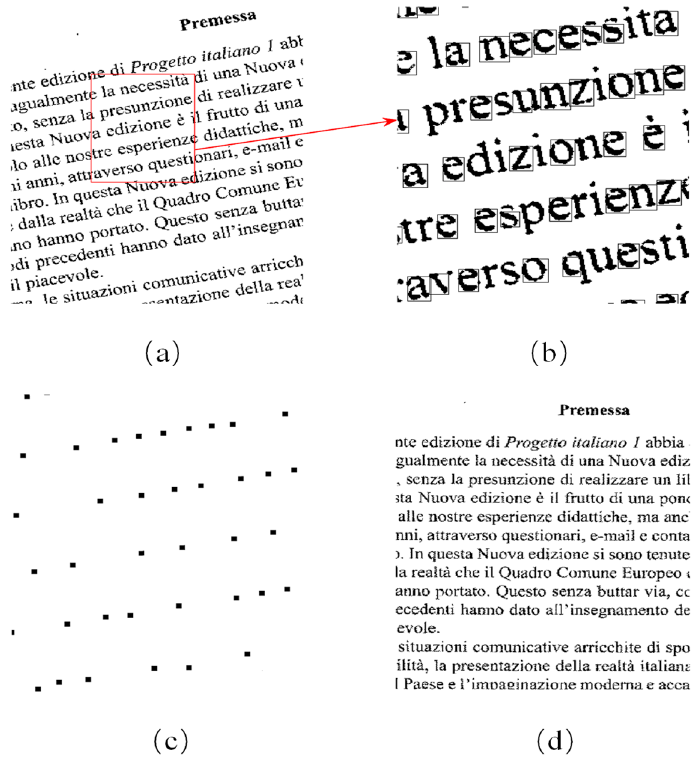
Figure 4. Document skew detection and correction: ( a ) original document image; ( b ) the document image with bounding boxes; ( c ) the positions of ECCs; ( d ) the corrected document image.